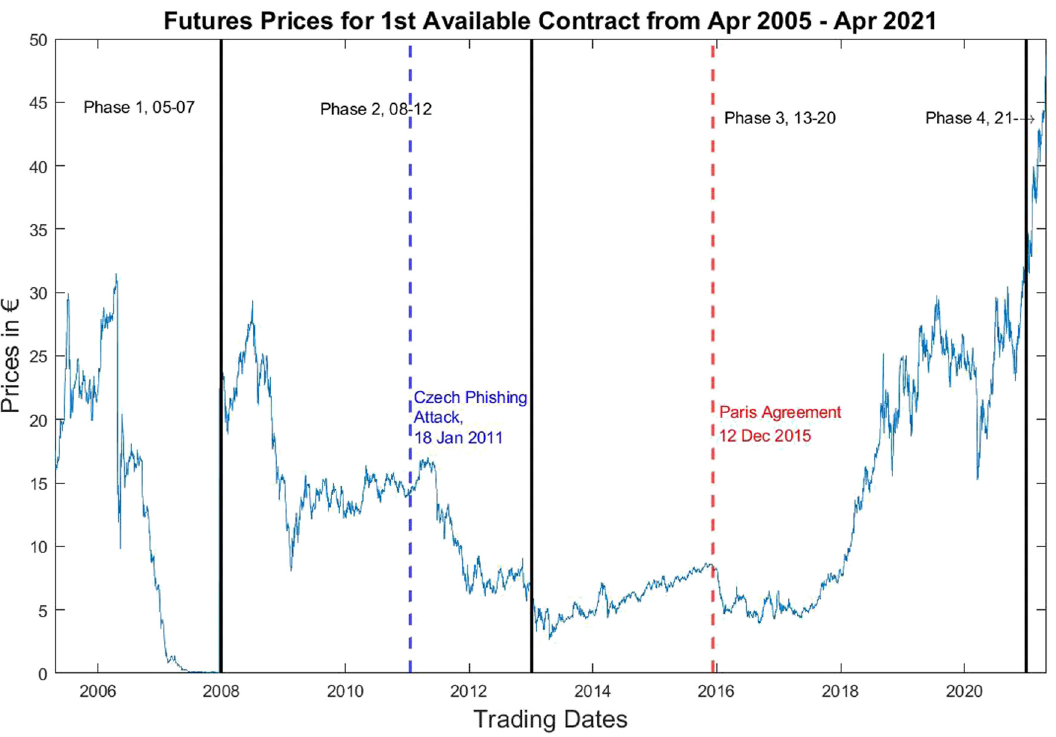
Figure 3: Path of prices of fi rst available EUA futures contract for the period from April 22, 2005, to April 30, 2021.